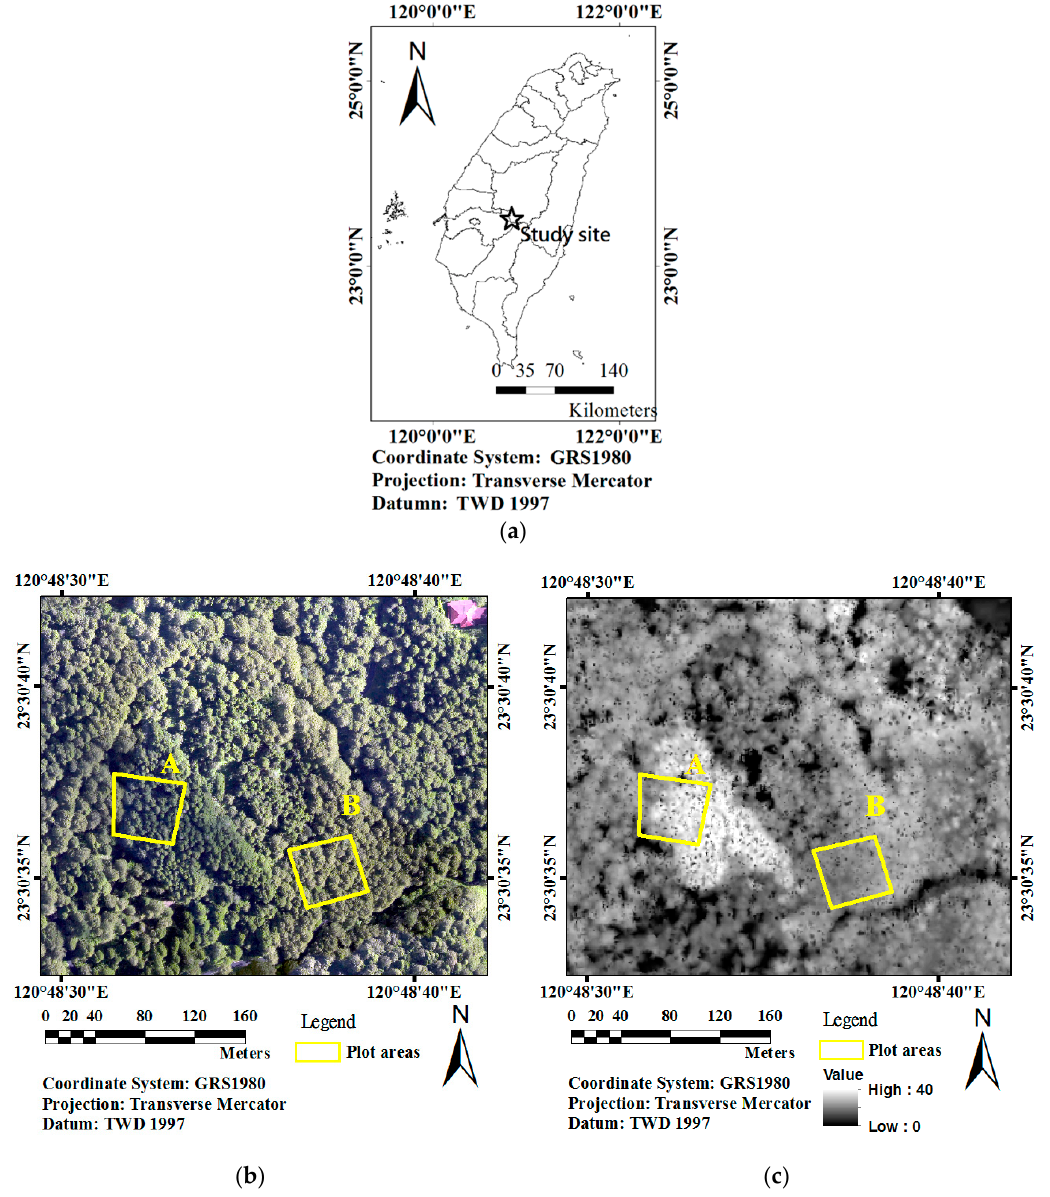
Figure 1. Illustration of the study site location ( a ) and its ortho-rectified bitmap image ( b ) and canopy height model ( c ).